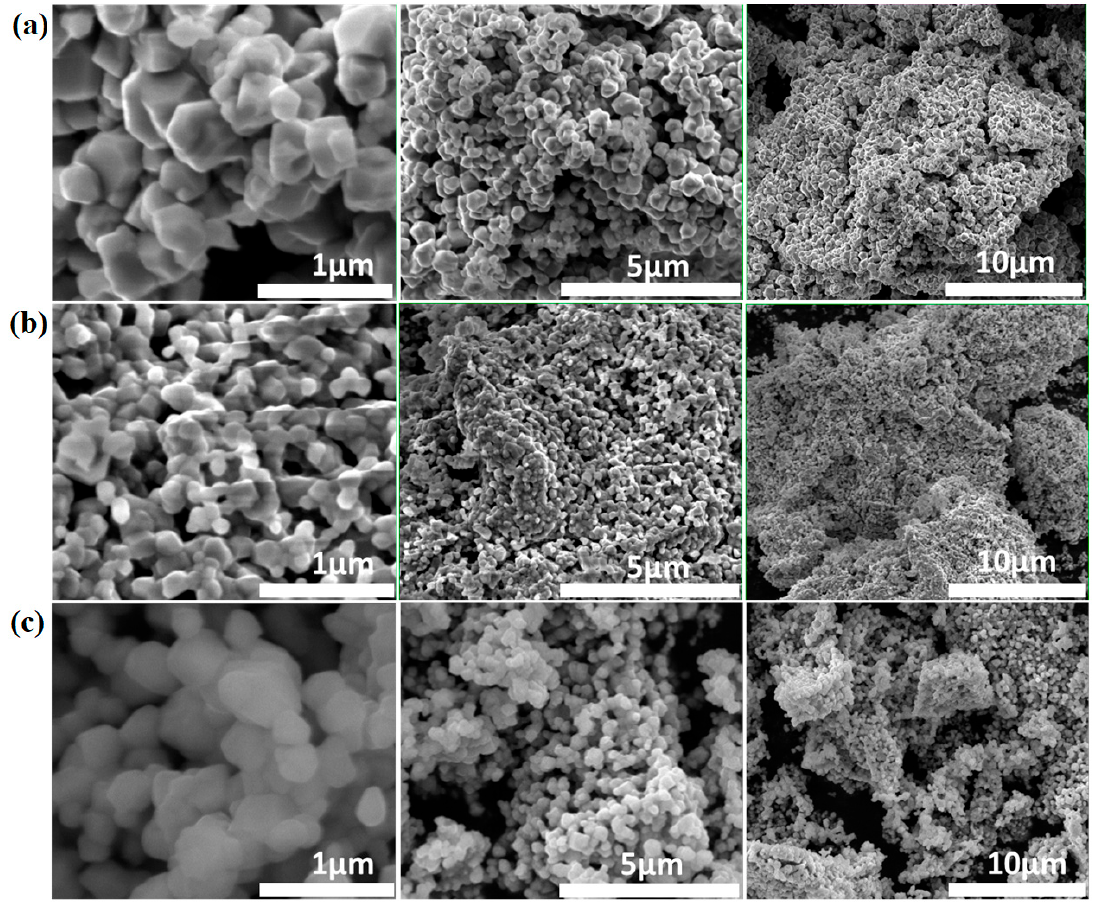
Figure 4. Typical SEM images of ( a ) LRAC, ( b ) LRNI, and ( c ) LRACNI, at different magnifications, showing different particle sizes due to the different effects of cornstarch as a gelling agent.